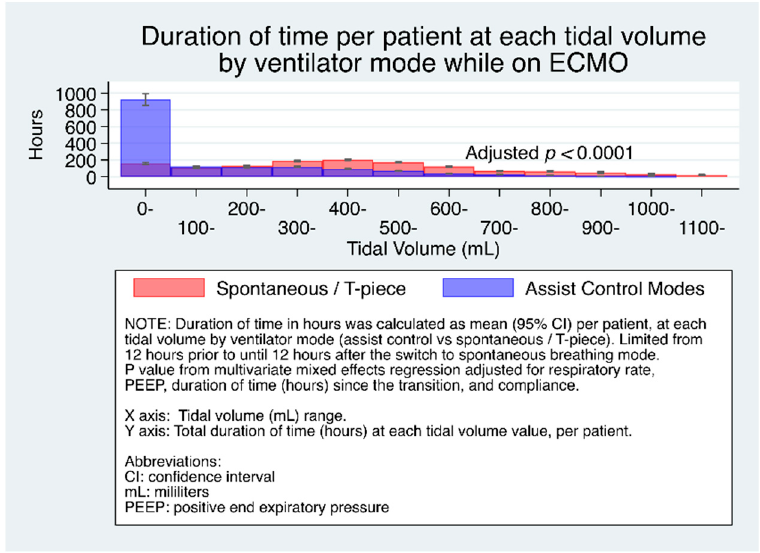
Figure 2. Duration of time (median, 95% CI) per patient at each tidal volume range by ventilator mode.